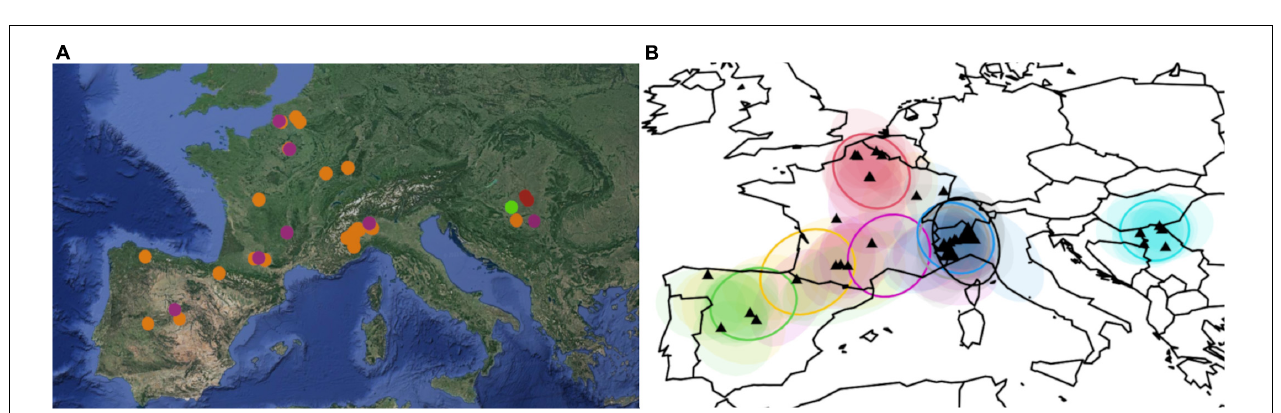
FIGURE 3 | Principal coordinates analysis (PCoA) showing variation between the 54 chloroplast (cp) genomes. Each point represents a haplotype. Geographical regions are marked by different colors.